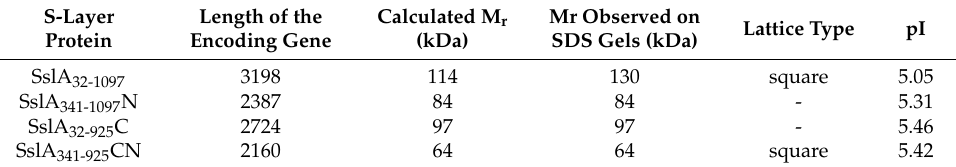
Table 1. Survey of the properties of the recombinant mature SslA and of the truncated SslA forms. Molecules 2016 , 21 , 1117 S-Layer Length of the Calculated M r Mr Observed on Lattice Type pI Protein Encoding Gene (kDa) SDS Gels (kDa) SslA 32-1097 3198 114 130 square SslA 341-1097 N square